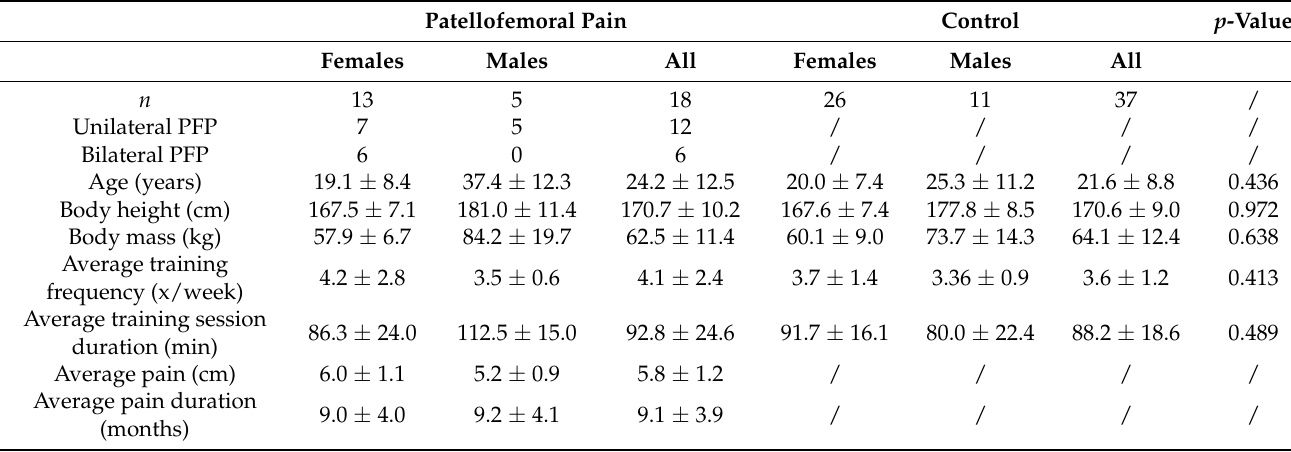
Table 1. General characteristics of the patellofemoral pain and the control